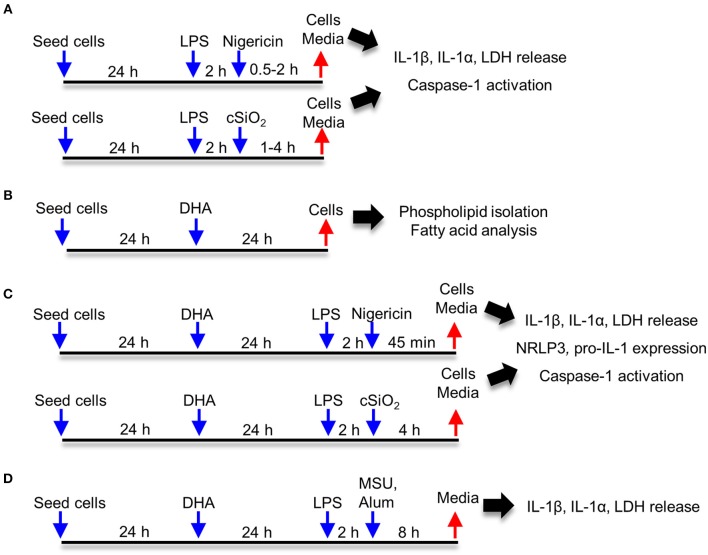
Experimental design. Studies focused on (A) characterization of cSiO2- and nigericin-induced inflammasome activation, IL-1 cytokine release and cell death in RAW-WT and RAW-ASC macrophages, (B) assessing effects of DHA supplementation on the fatty acid profile of membrane phospholipids, (C) determining how DHA impacts inflammasome activation, IL-1 cytokine release and cell death, and (D) assessing how DHA impacts inflammasome activation by monosodium urate (MSU) and alum crystals.